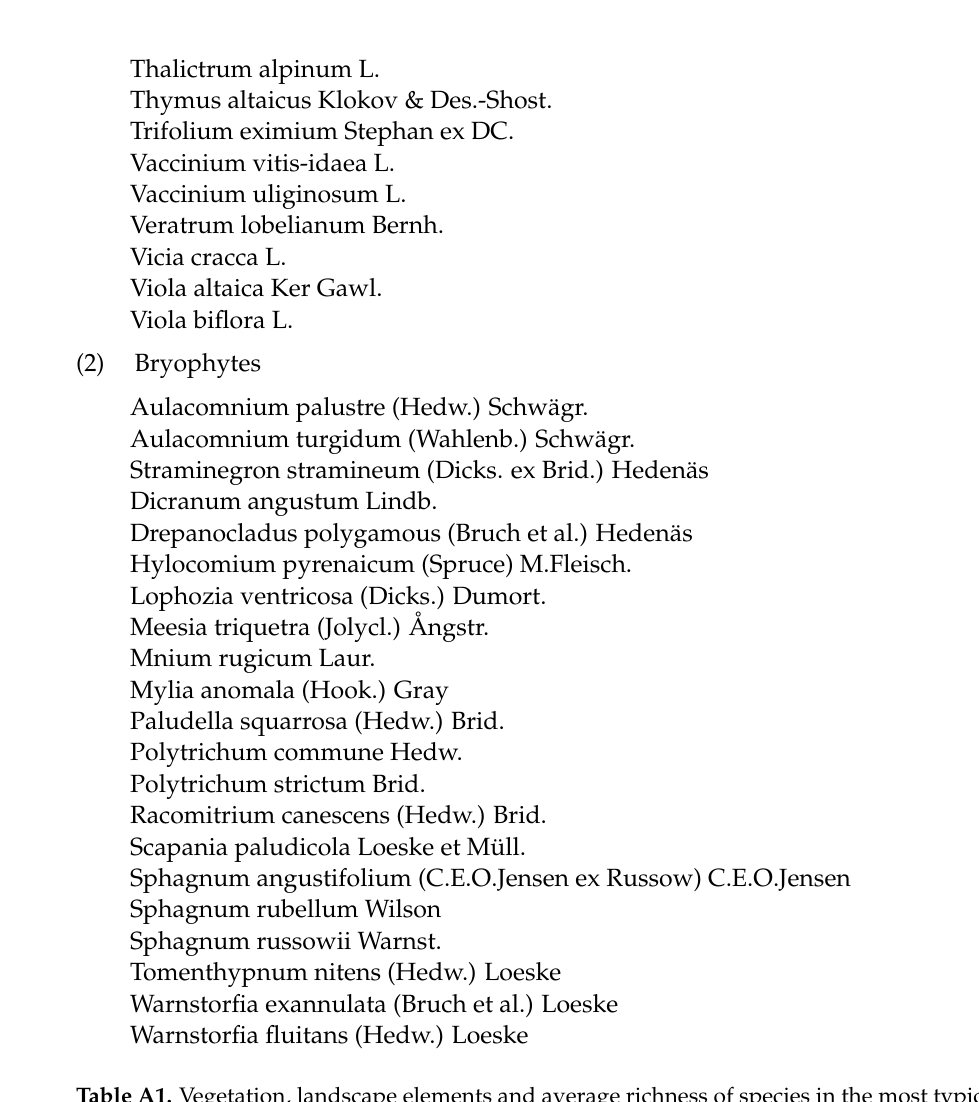
Table A1. Vegetation, landscape elements and average richness of species in the most typical plant communities of the Adyr-Chem key site (palsa